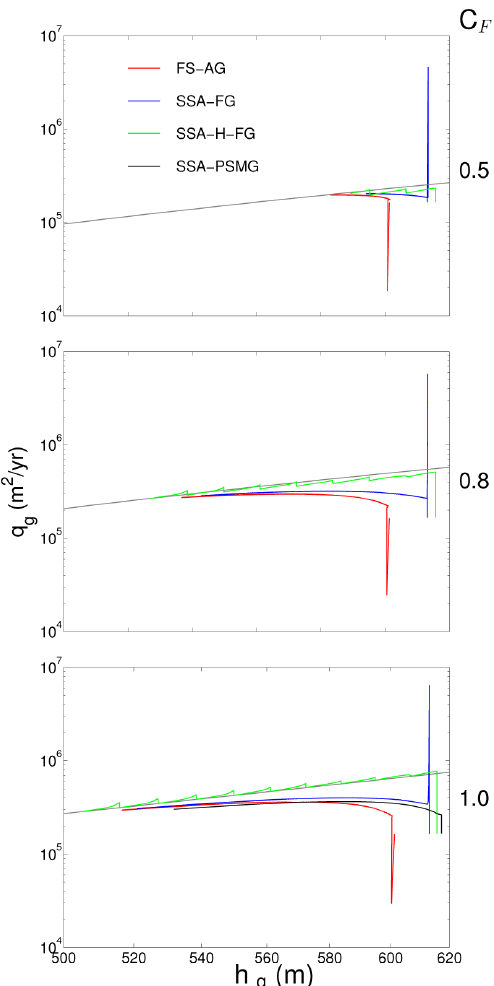
Fig. 5. GL ice flux q g as a function of GL ice thickness h g for the four models and for the three different buttressing values, compared with the Schoof (2007) solution (in